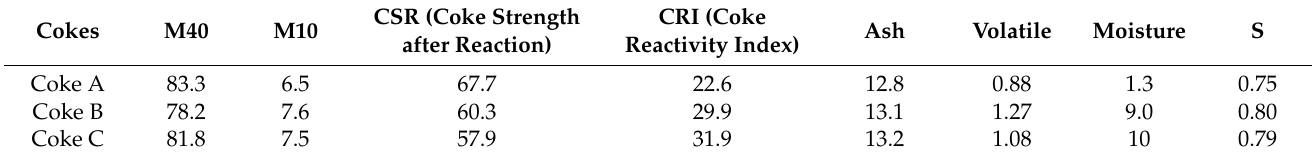
Table 1. Metallurgical property and component of cokes (wt%).